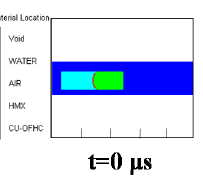
Figure 18. Shock wave propagation in the pit stage.